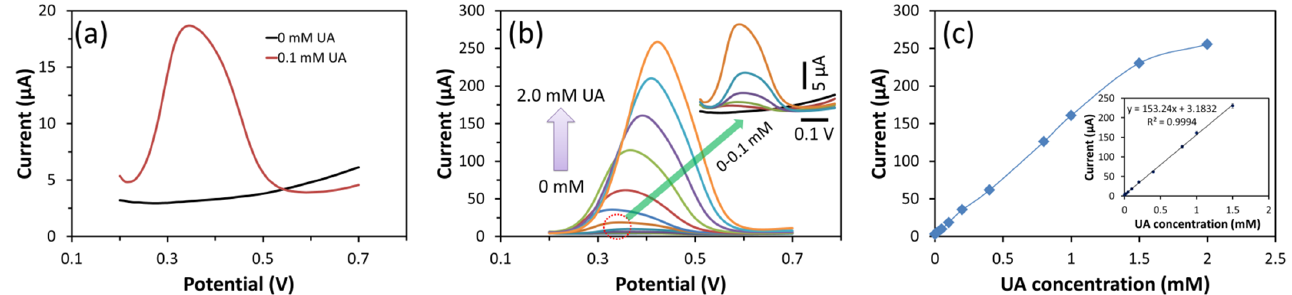
Figure 6. DPV response of cobalt oxide puffy balls/GC sensor towards 0 mM and 0.1 mM UA ( a ), from 0 to 2.0 mM UA in PBS buffer (pH = 7.4) ( b ), and current response vs. UA concentration plot ( c ). Inset b is the DPV response at a low-concentration range (0 to 0.1 mM) of UA. Inset c represents the calibrated plot showing a slope (153.24 µA/mM) and R 2 of 0.9994. Table 1. Comparison of electrochemical non-enzymatic UA sensing performance of cobalt oxide puffy balls/GC sensor with previously published literature.